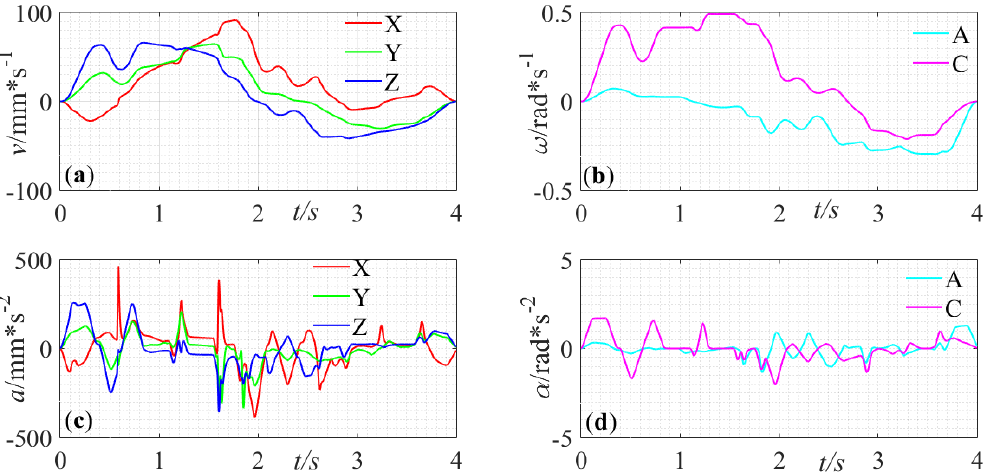
Figure 20. Real axial kinematics—( a ) Translational axial velocities. ( b ) Rotary axial velocities. ( c ) Translational axial accelerations. ( d ) Rotary axial